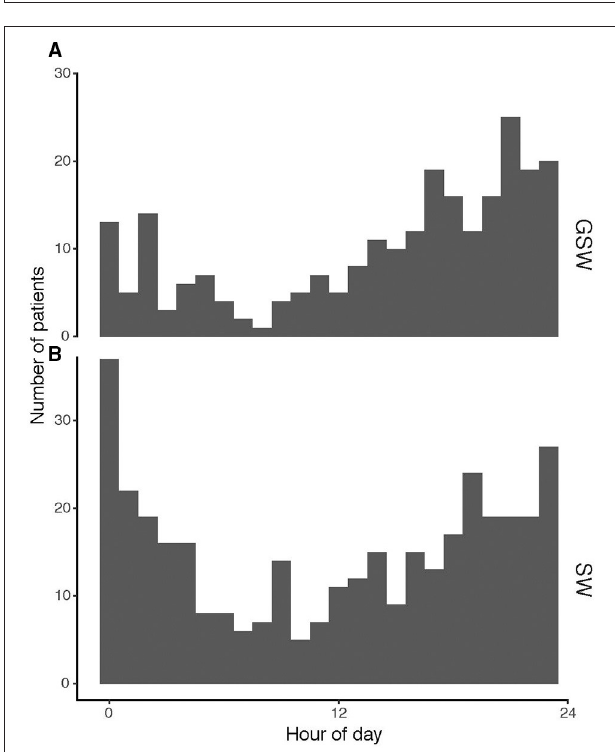
FIGURE 5 | Time of day distributions for trauma in (A) GSW and (B) stab. GSW, gunshot wounds.